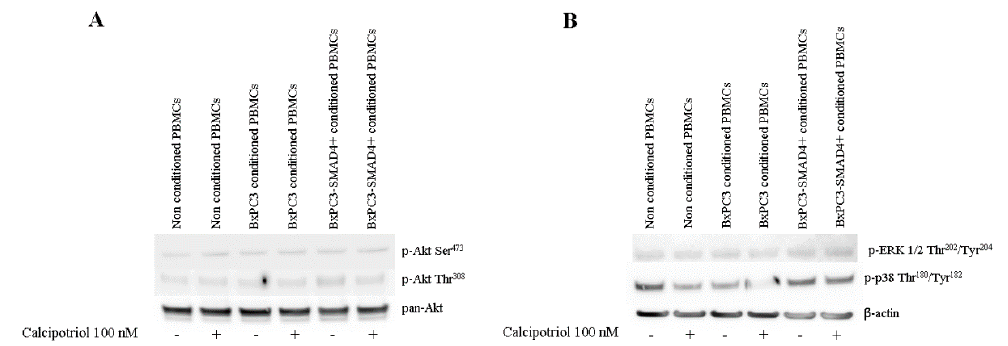
Calcipotriol treatment did not modify Annexin V expression by PDAC cell lines. PDAC cell lines.